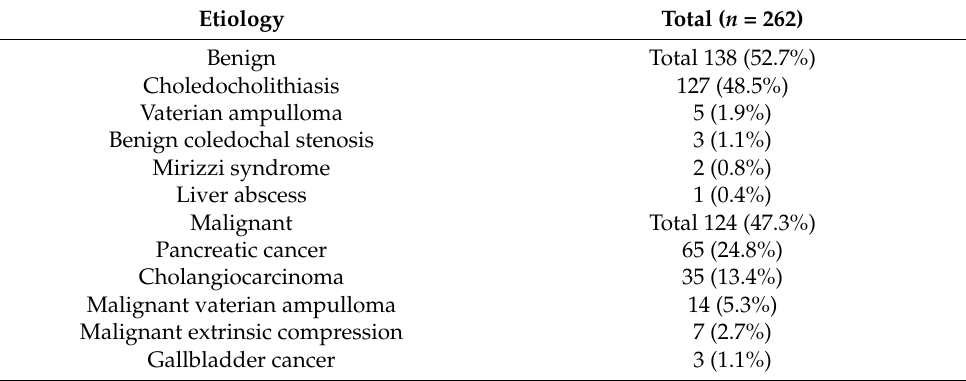
Table 1. Comparison of etiology between patients with malignant and benign disease.